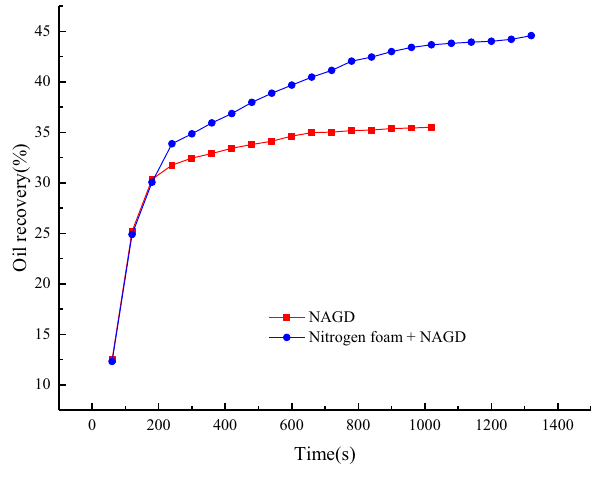
Fig. 8 The different oil recovery between NAGD + NAGD/ nitro- gen foam (experiment condition: temperature 80 °C, gas cap volume 0.5 PV, pressure of gas cap 1 MPa, formation dip angle 15°, back pressure 0.5